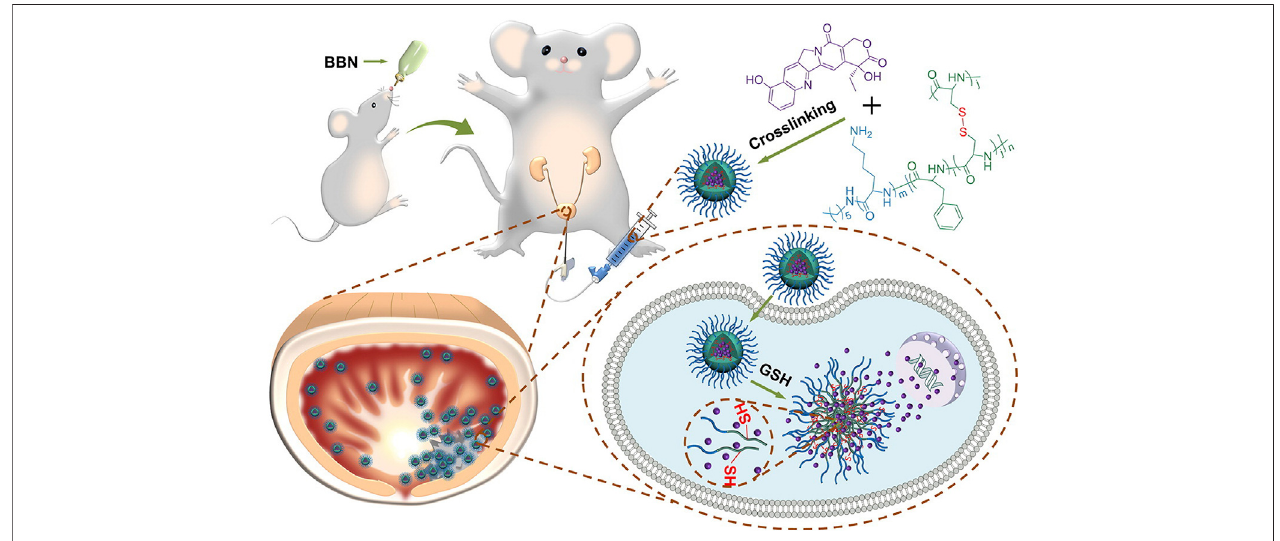
FIGURE 1 | After intravesical instillation of NG/HCPT, the selective accumulation of nanodrugs in tumor tissue fi nally releases HCPT triggered by GSH(Guo et al., 2017).